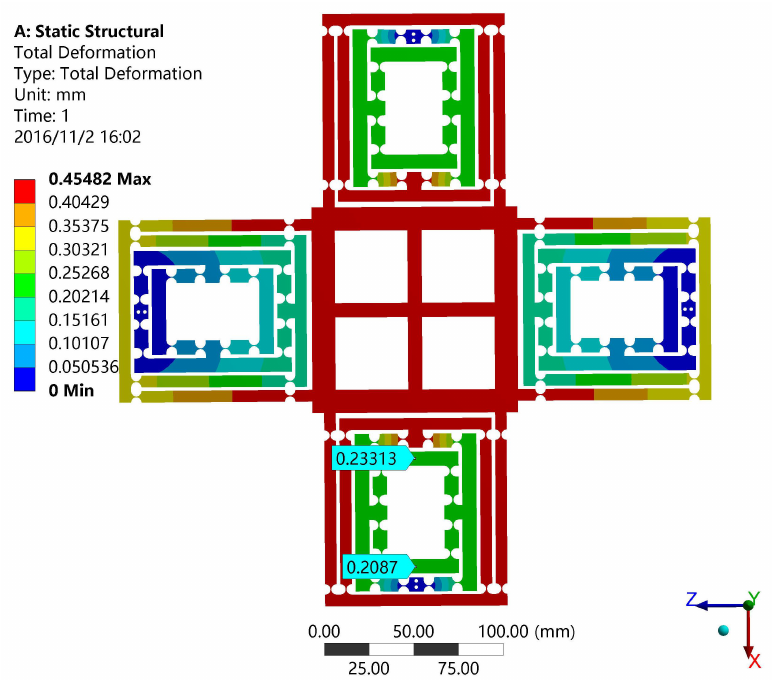
Figure 11. The input stiffness simulation results of DCPM.